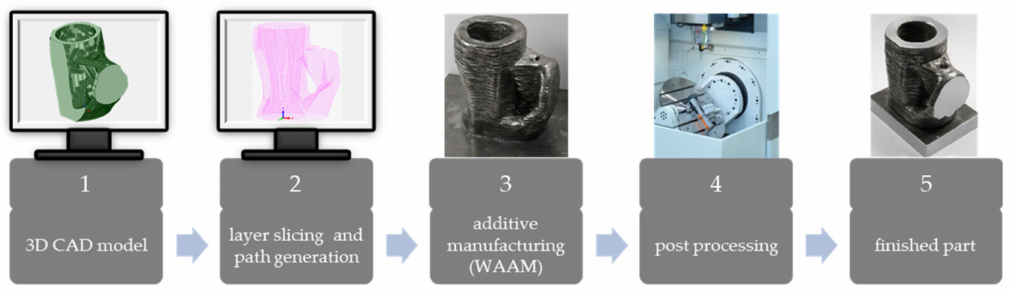
Figure 1. Process chain of additive manufacturing using DED-Arc according to